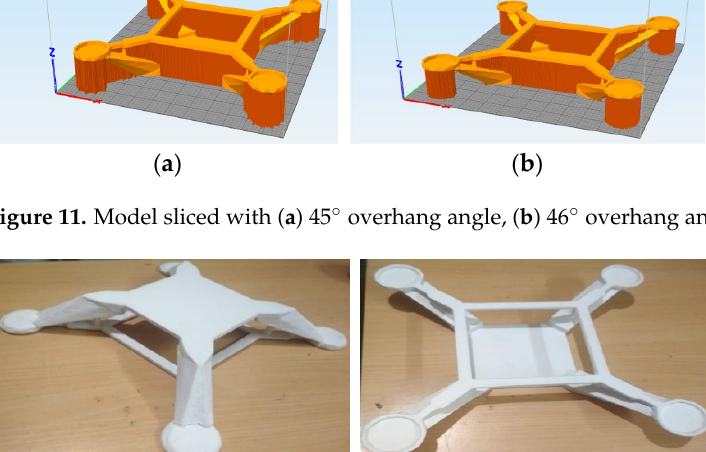
Figure 11. Model sliced with ( a ) 45° overhang angle, ( b ) 46° overhang angle.